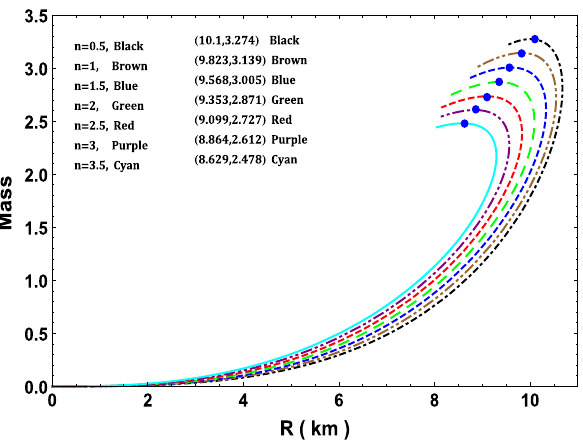
Fig. 8 M – R graphs for non-rotating case with a = 0 . 001 km − 2 and β = 0 . 2